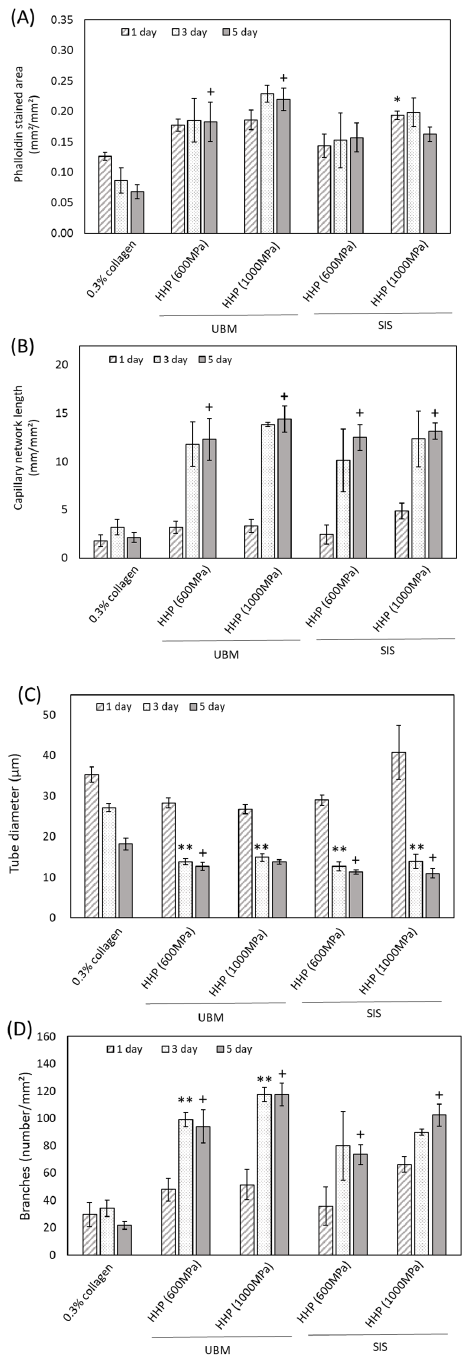
Figure 9. Quantitative analysis of capillary network structure formed on d-ECM hydrogels. ( A ) Phalloidin stained area, ( B ) capillary network length, ( C ) tube diameter, ( D ) branches. The asterisk (*) shows a significant difference ( p < 0.05) between collagen gel and d-ECM hydrogel at day 1. Two asterisks (**) show a significant difference ( p < 0.05) between collagen gel and d-ECM hydrogel at day 3. The cross (+) shows a significant difference ( p < 0.05) between collagen gel and d-ECM hydrogel at day 5. HHP represents the method of decellularization of each tissue (urinary bladder matrix (UBM) and small intestine submucosa (SIS)).